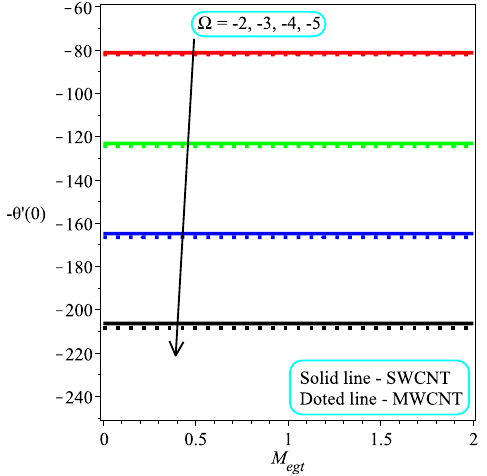
Figure 16. Repercussion of Ω with κ = 1 φ = 0.1, ω = π /3, N = 2, Υ = 1, Pr = 100 on − θ (cid:48) ( 0 ) .